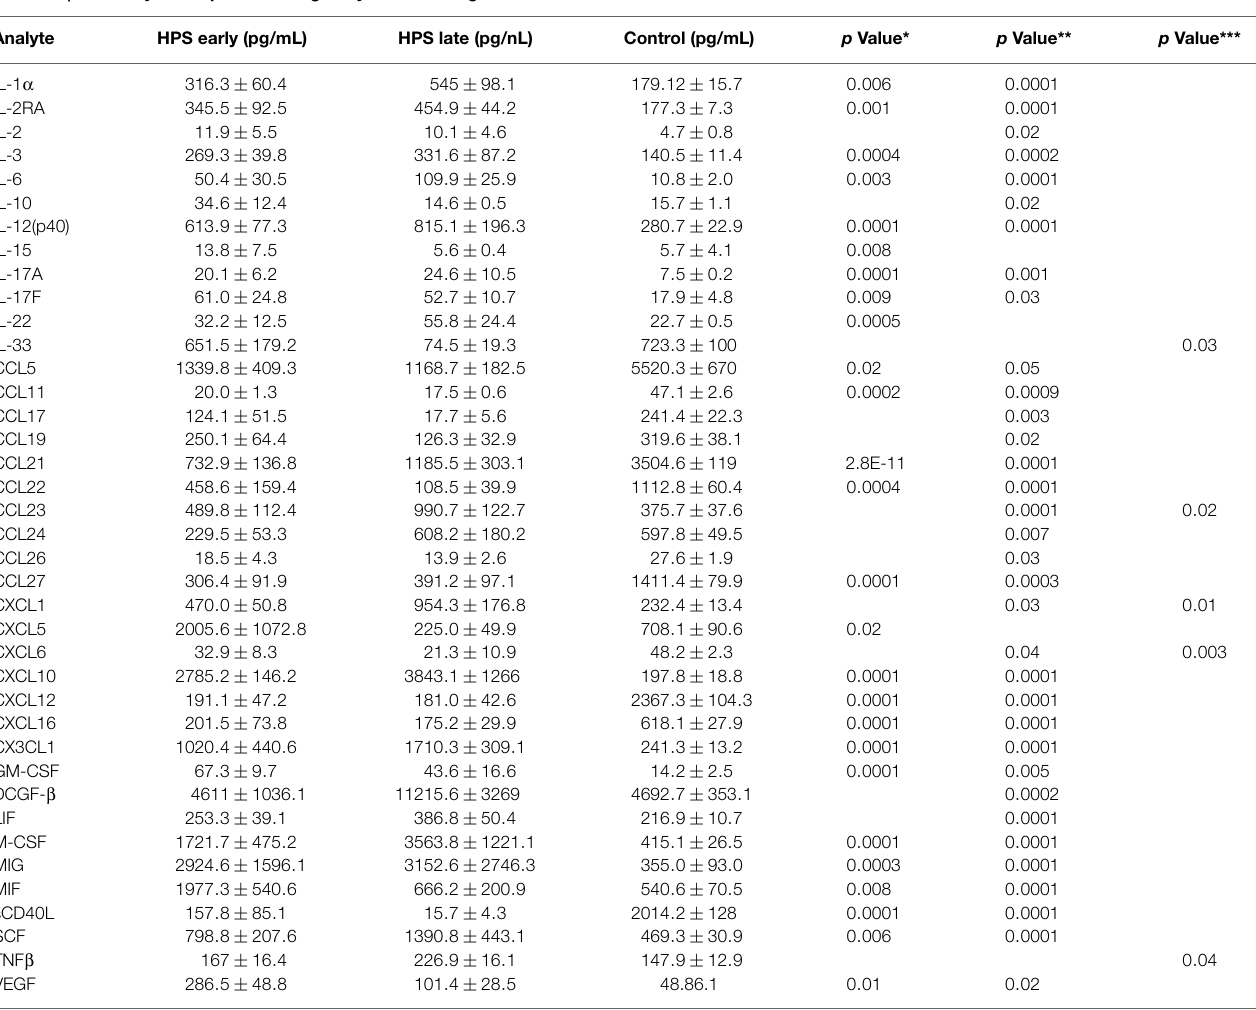
TABLE 5 | Serum cytokine profile during early and late stages of HPS . Analyte HPS early